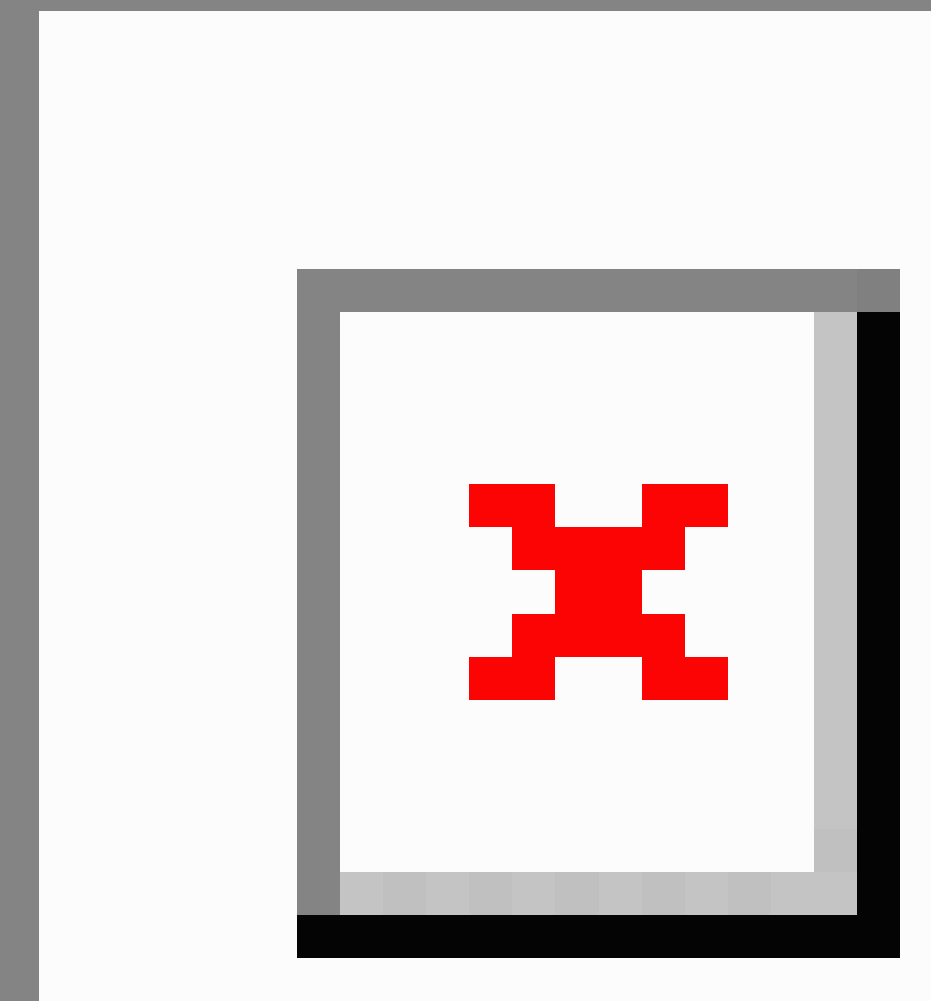
Figure 1. Flow diagram of screening process and